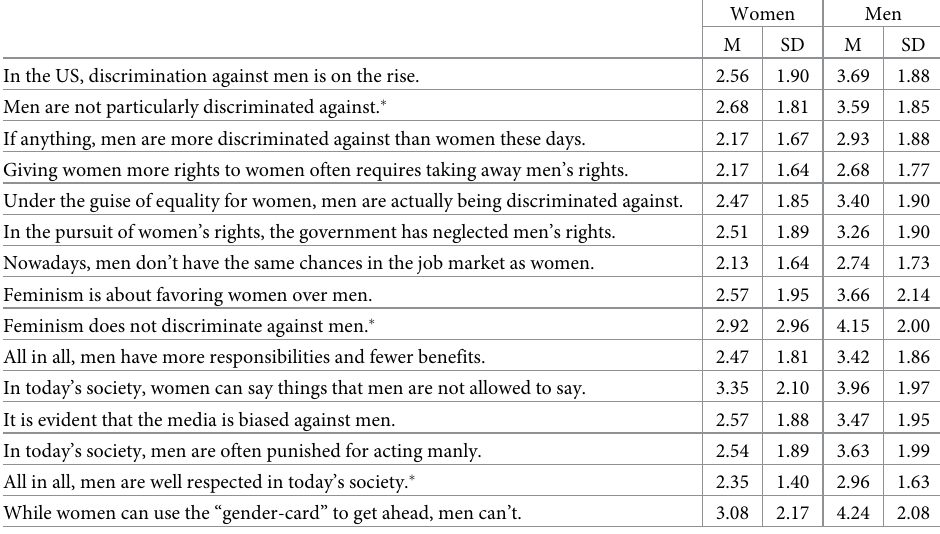
Table 3. BSS scale item means and standard deviations by